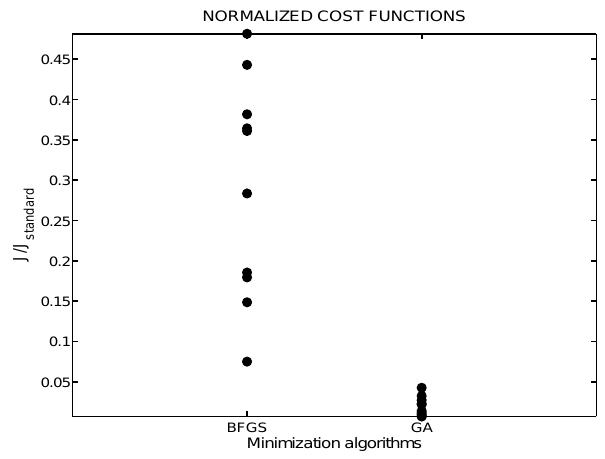
Figure 1. Cost function reductions for the 10 twin experiments that were performed with the BFGS algorithm (BFGS) and with the genetic algorithm (GA). Cost functions ( J ) at the end of the minimization process were normalized by the value of the cost function representing the mismatch between the synthetic data and the model outputs computed with the standard parameters of OR- CHIDEE (J standard